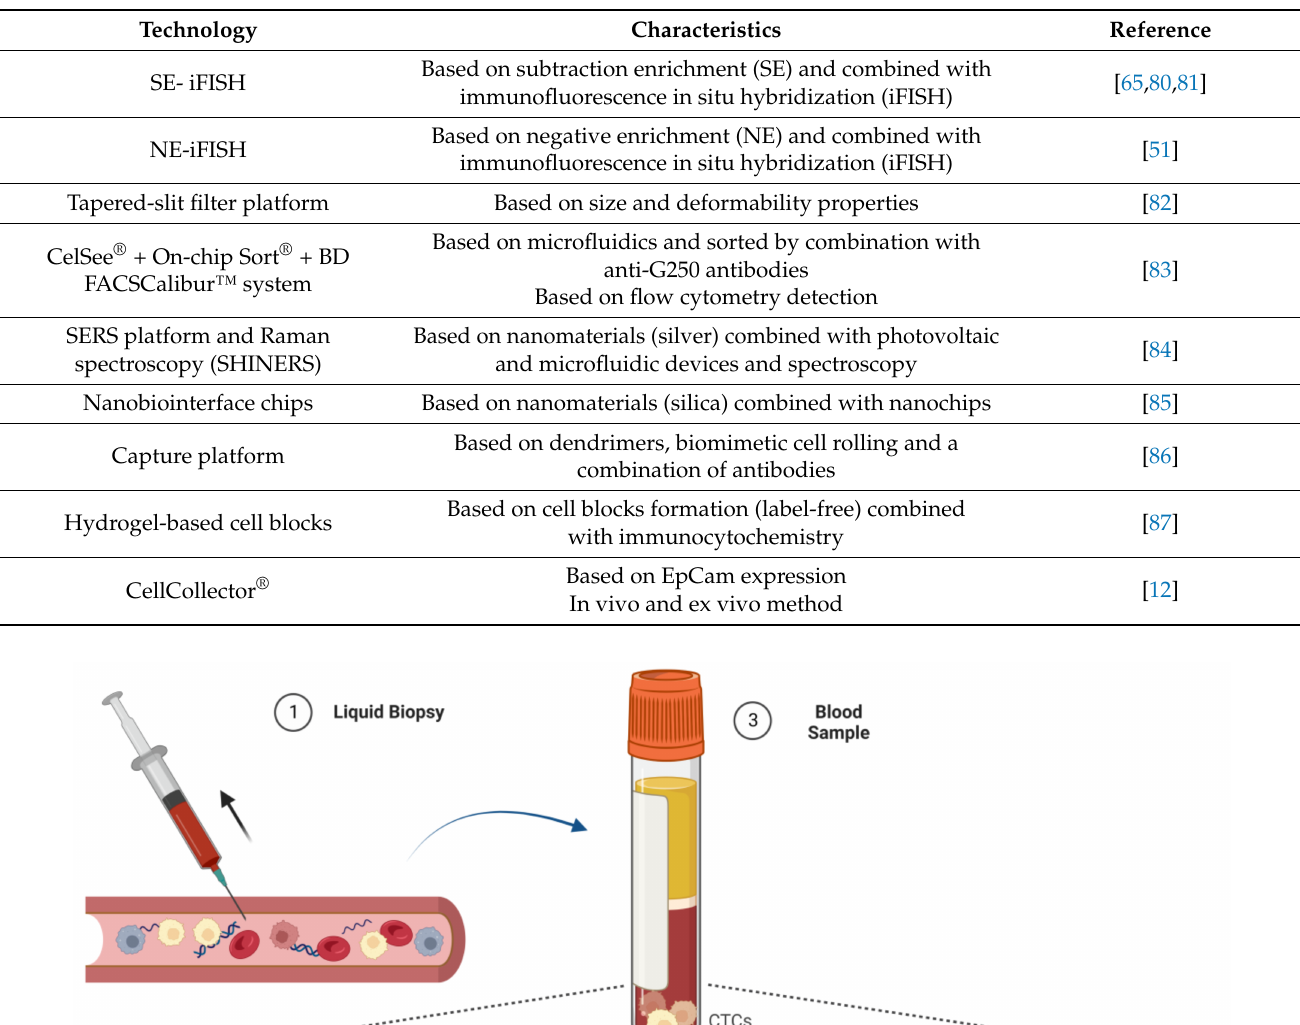
Table 1. Summary of the main emerging technologies applied in mRCC-CTCs.